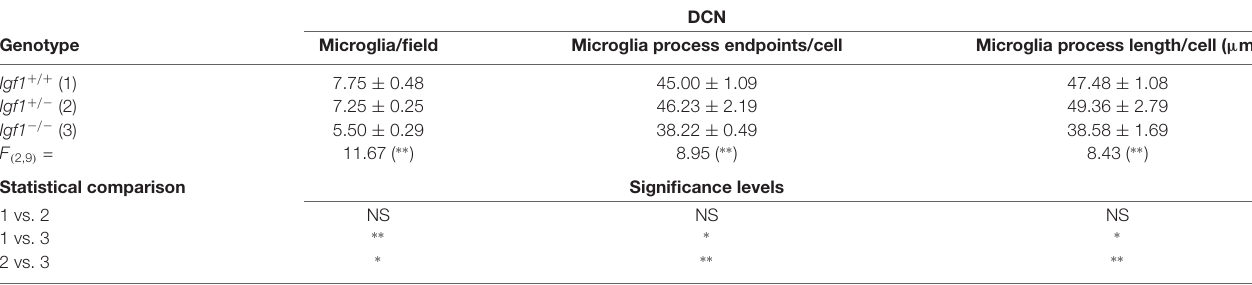
TABLE 2 | Morphometric analysis of microglial ramification in the dorsal cochlear nucleus (DCN).